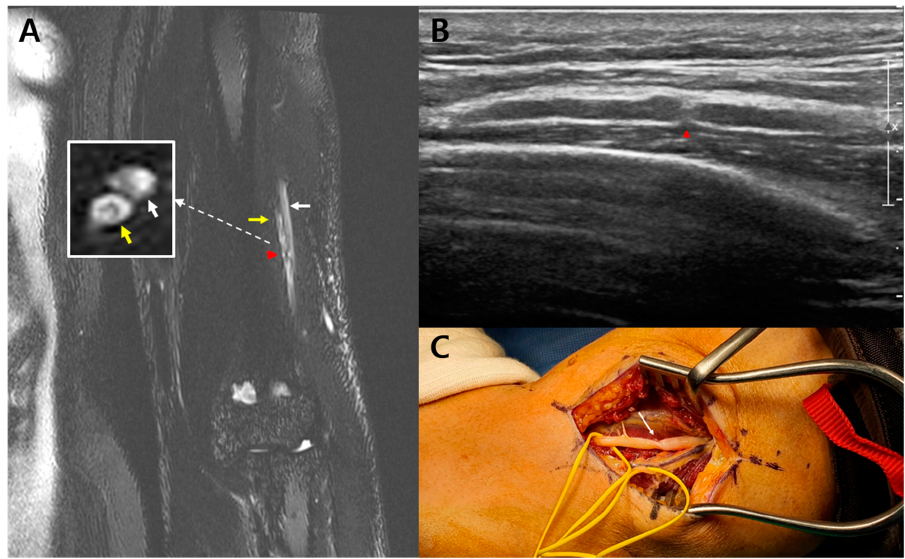
Figure 1. Case 1: ( A ) High-resolution magnetic resonance neurography reveals a focal constriction (red arrowhead) of the left posterior interosseous nerve (PIN) (yellow arrows) within the epineurium of the left radial nerve 8.9 cm proximal to the lateral epicondyle. The left superficial radial nerve (white arrows) is swollen. Further, the bull’s eye sign (yellow arrow in white square) is observed juxta-proximal to the constriction site of the left PIN; ( B ) Longitudinal ultrasound reveals constriction (red arrowhead) of the left radial nerve; ( C ) Intraoperative finding confirms constriction (write arrow) of the left radial nerve.